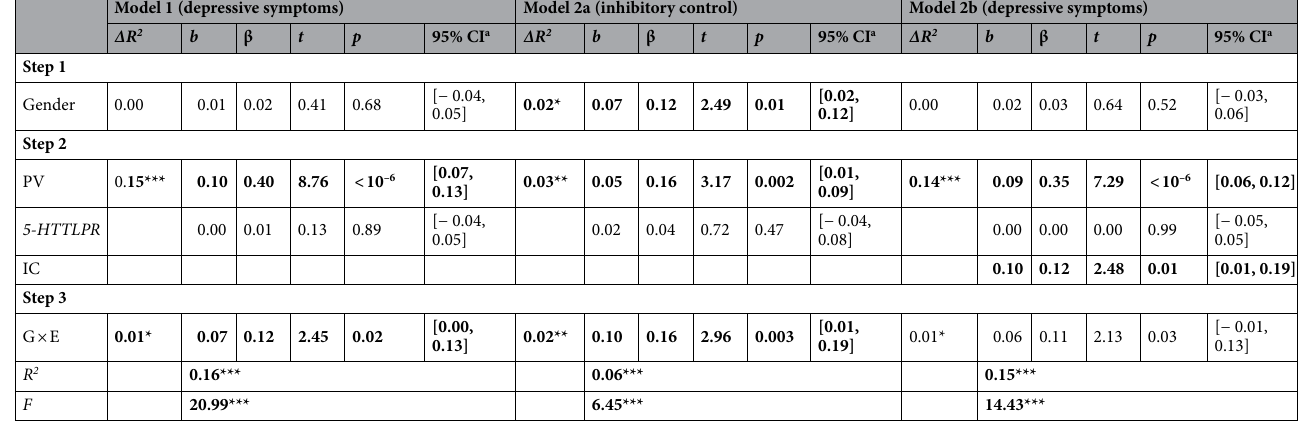
Table 3. Test of mediated moderation in subsample 1. Significant results are highlighted by bold face. PV peer victimization (standardized); IC inhibitory control; G × E 5-HTTLPR × peer victimization. * p < 0.05; ** p < 0.01; *** p < 0.001. a Bootstrapping based confidence intervals.